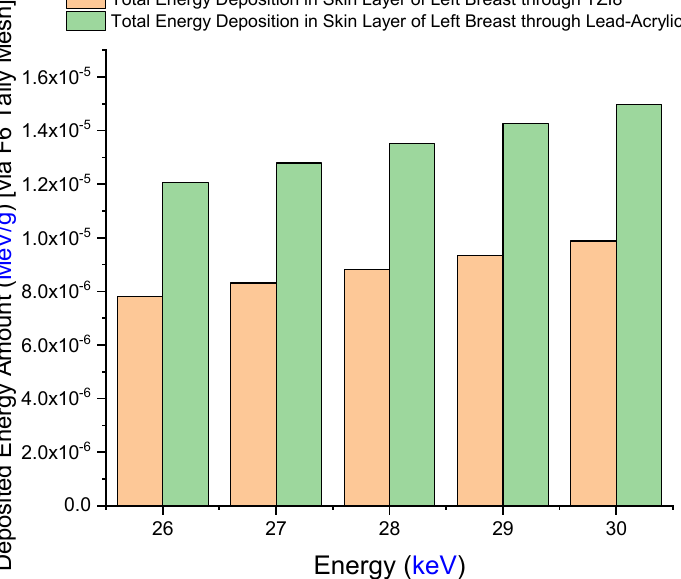
Figure 10. Variation in deposited energy amounts in left breast using TZI8 and lead ‐ acrylic shielding screens.